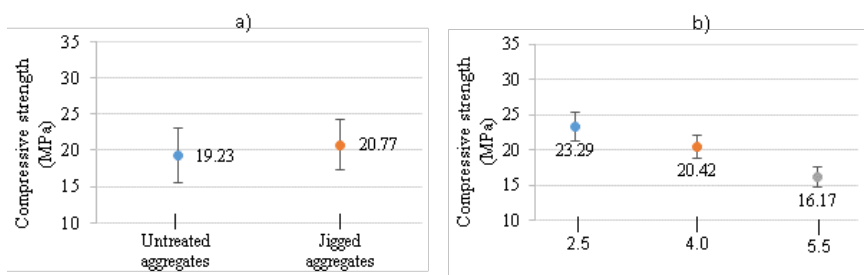
Figure 9. Isolated effects in axial compressive